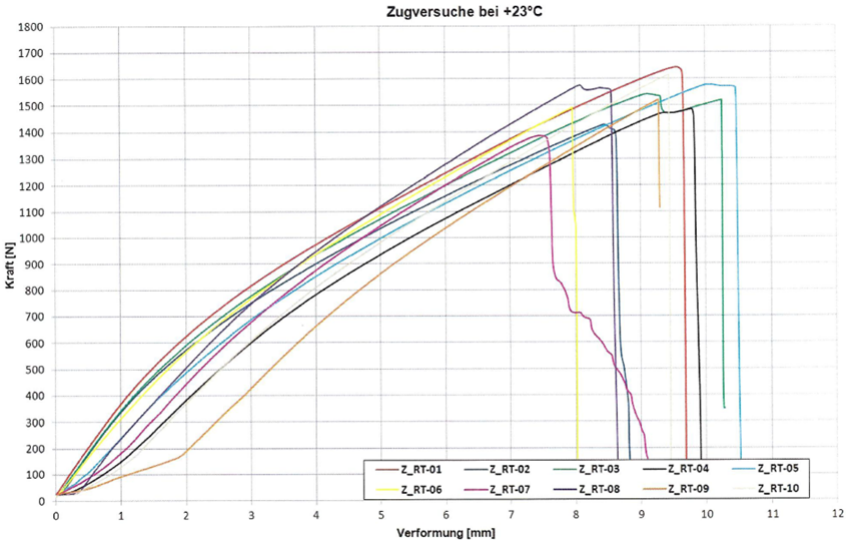
Fig. 7 Force-displacement curves for a 120 mm x 10 mm silicone joint with a height of 8 mm loaded in tension at